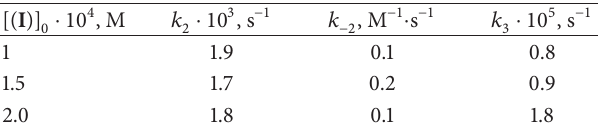
Figure 4: Kinetics of ( I ) decomposition in 0.05 M phosphate buffer, pH 7.0 at 25 ∘ C. Starting ( I ) concentrations are equal to 1.5 ⋅ 10 −4 (1) and 2 ⋅ 10 −4 (2) M. Circles are the experimental data. Solid lines are the simulated curves, corresponding to the experimental points. Simulation was made by means of a system of differential equations (6). ( I ) is the complex [ Fe 2 ( SC 5 H 11 NO 2 ) 2 ( NO ) 4 ] SO 4 ⋅ 5 H 2 O. Table 1: Results of kinetic modelling calculations (denote the rate constants of the reactions that are given in the text).